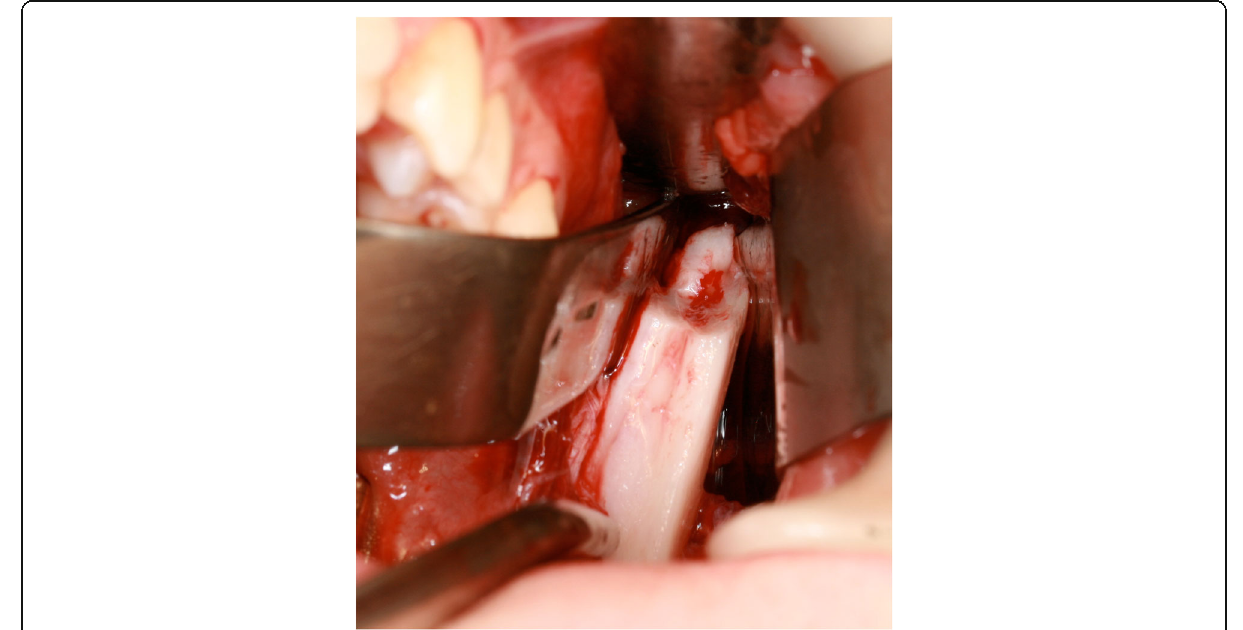
Fig. 9 Coronoid process surgically